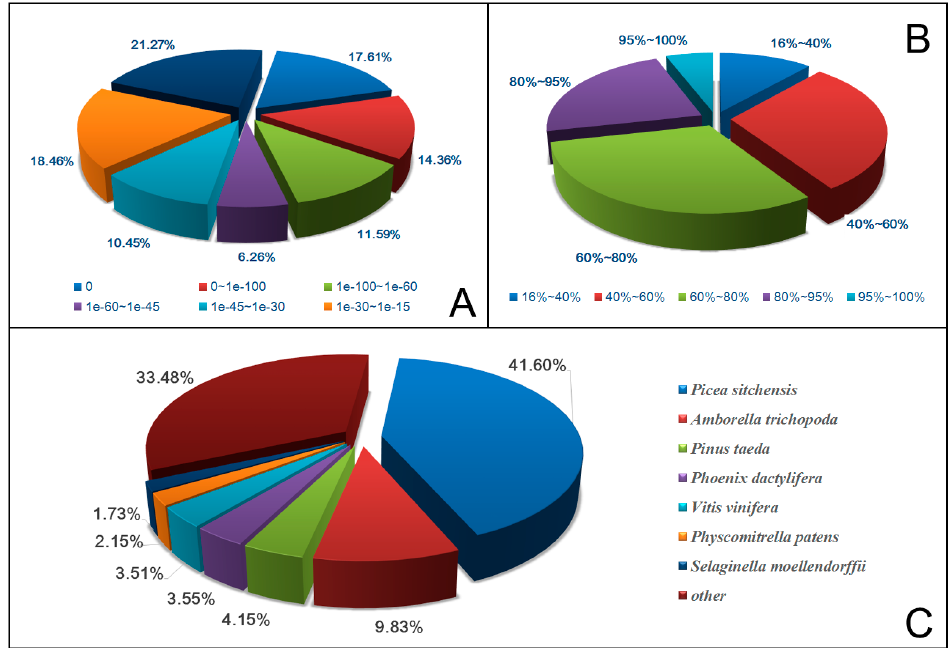
Figure 2. e -Value ( A ); similarity ( B ); and species distributions ( C ) of the unigenes.